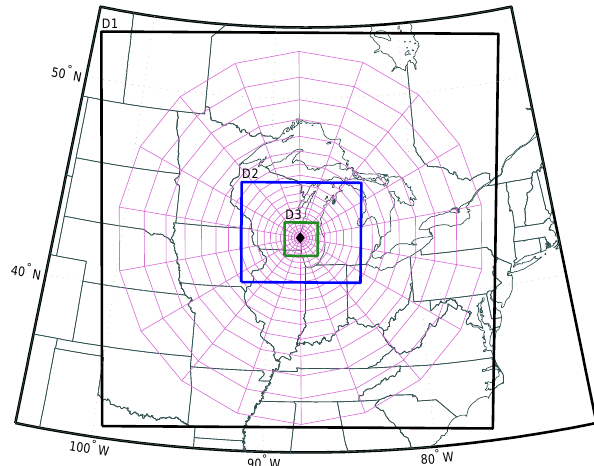
Fig. 1. Map showing the 3 WRF domains (black, blue and green) and the polar grid used for the inverse model (pink) (particle back-trajectories were mapped onto the polar grid for the Residence Time Analysis).